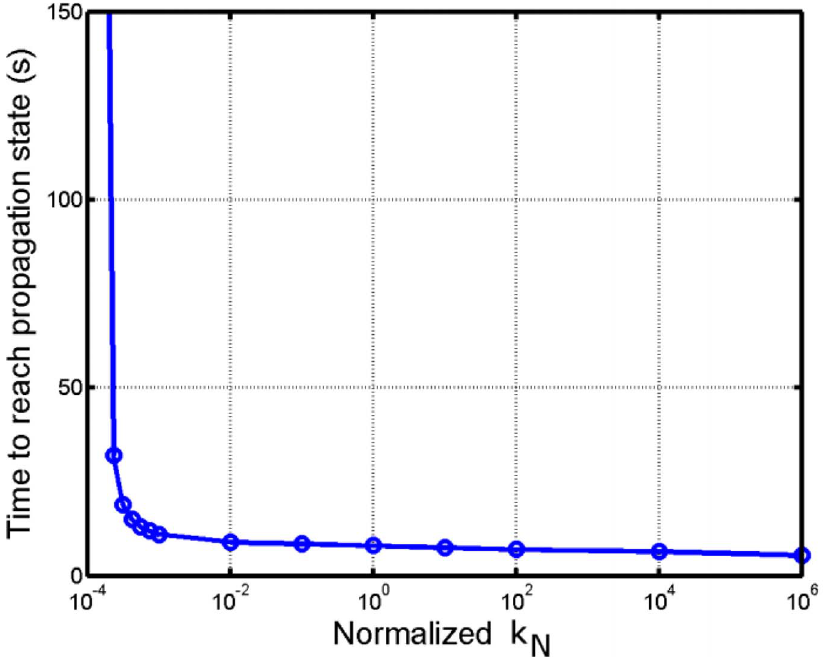
Figure 8. Dependence of actin-wave development on the precursor strength. Time required for actin waves to develop and propagate 0 : 5 m m away from the nucleation center is plotted as a function of precursor activity. k N is normalized around the value used in other simulations.